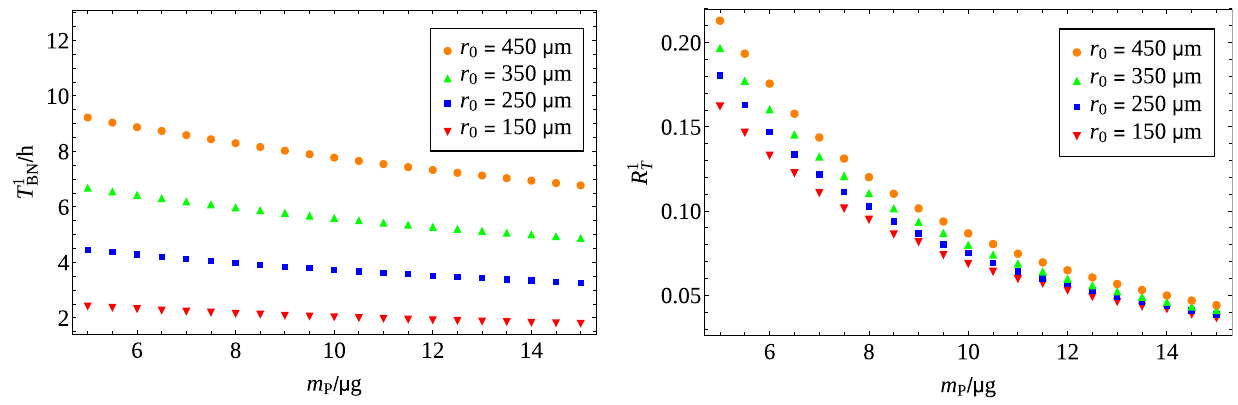
m P for different choices of the initial distance at the apoapsis, r 0 . In both panels, the color code is: r 0 = 450 μ m (orange circles), r 0 = 350 μ m (yellow triangles), r = 250 μ m (blue squares), and r 0 (red inverted triangles). Notice that for each choice of r 0 , ˙ θ 0 has been optimized to maximize the